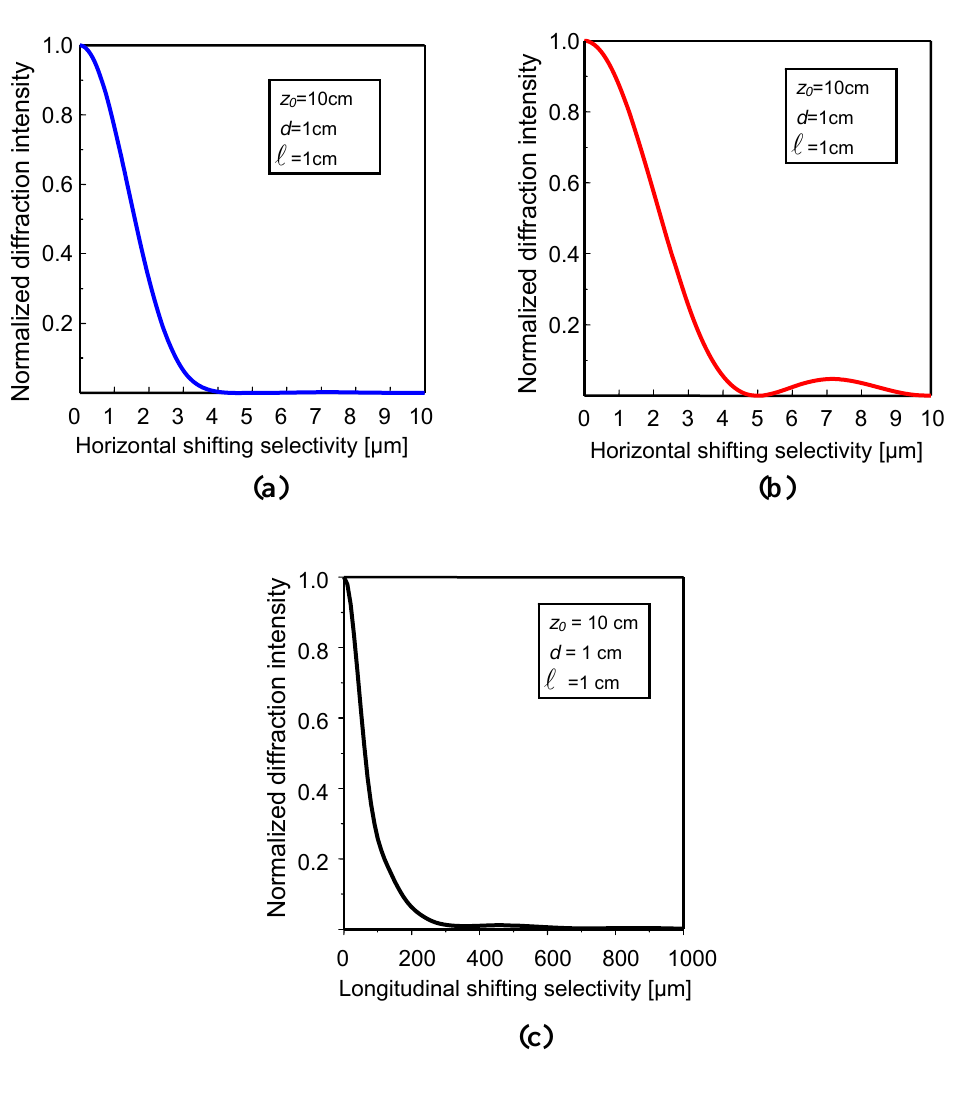
Figure 3. Theoretical shifting selectivity for random phase multiplexing in volume holographic